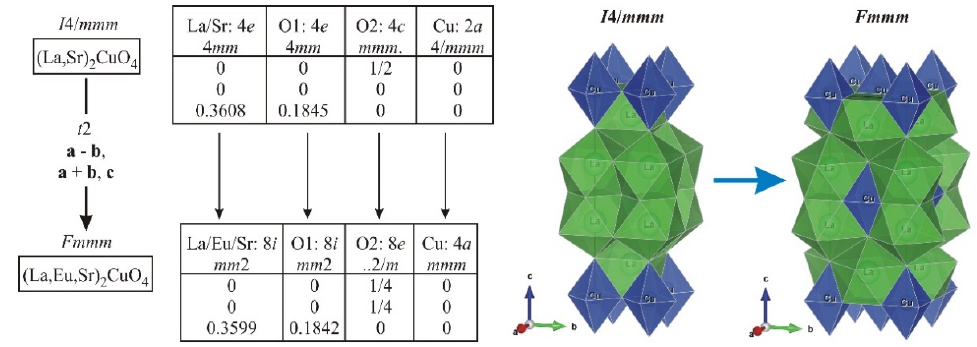
Figure 8. Transition from I4/mmm to Fmmm in La 1.81-x Sr 0.19 Eu x CuO 4 (x = 0 ÷ 0.4) single crystals.